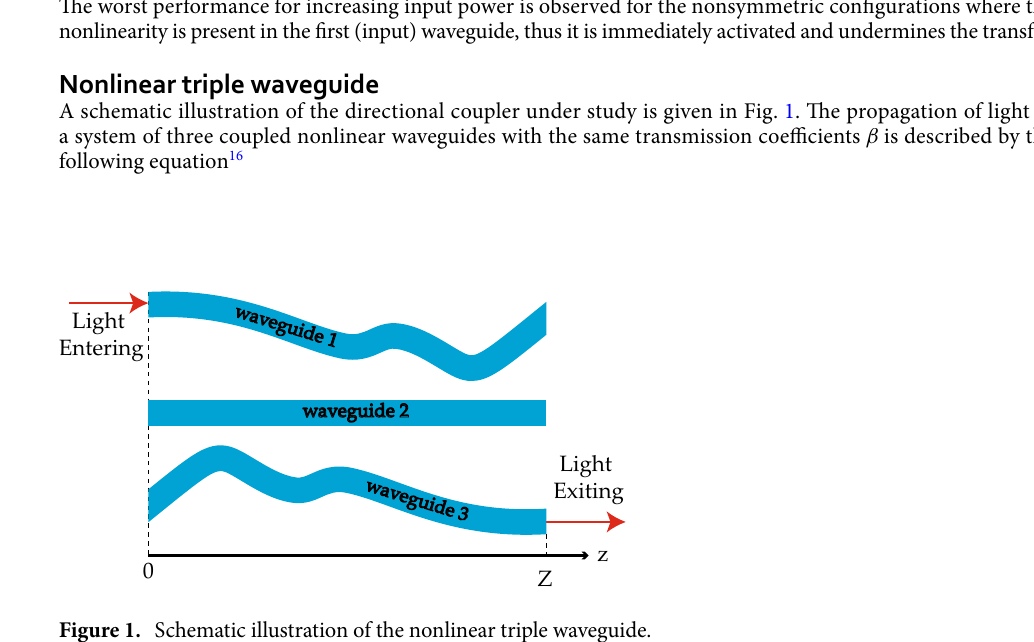
Figure 1. Schematic illustration of the nonlinear triple